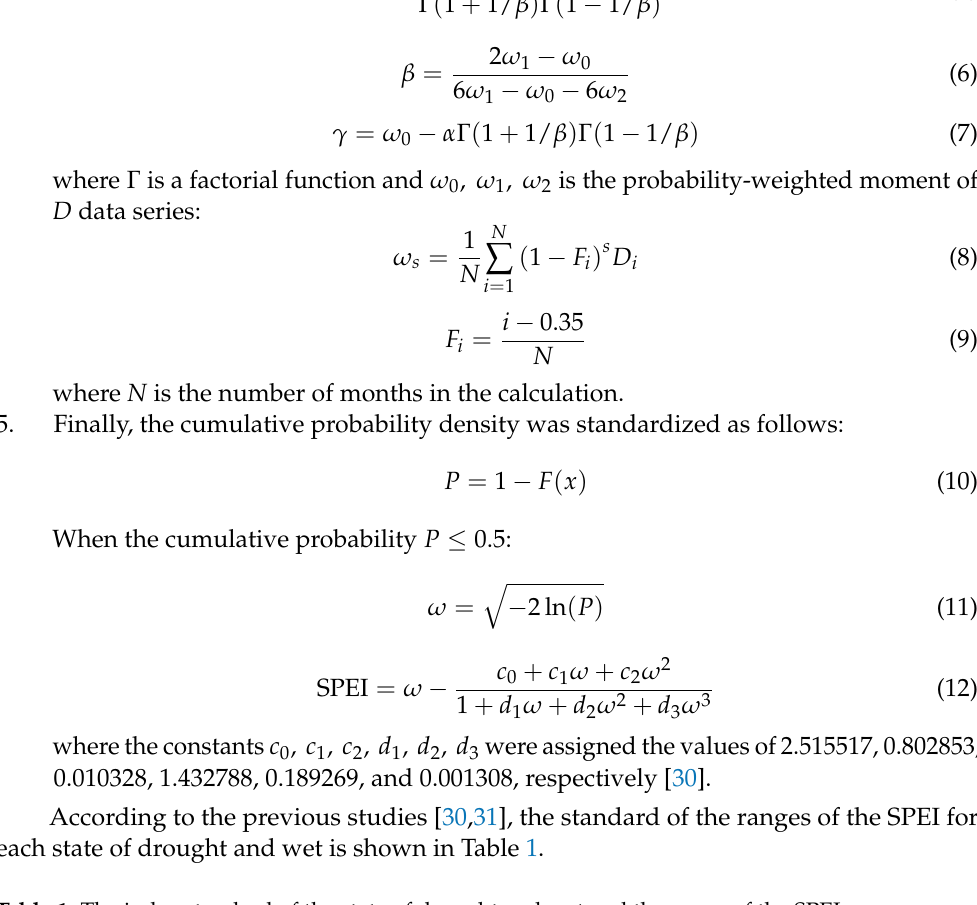
Table 1. The index standard of the state of drought and wet and the range of the SPEI. The State of Drought and